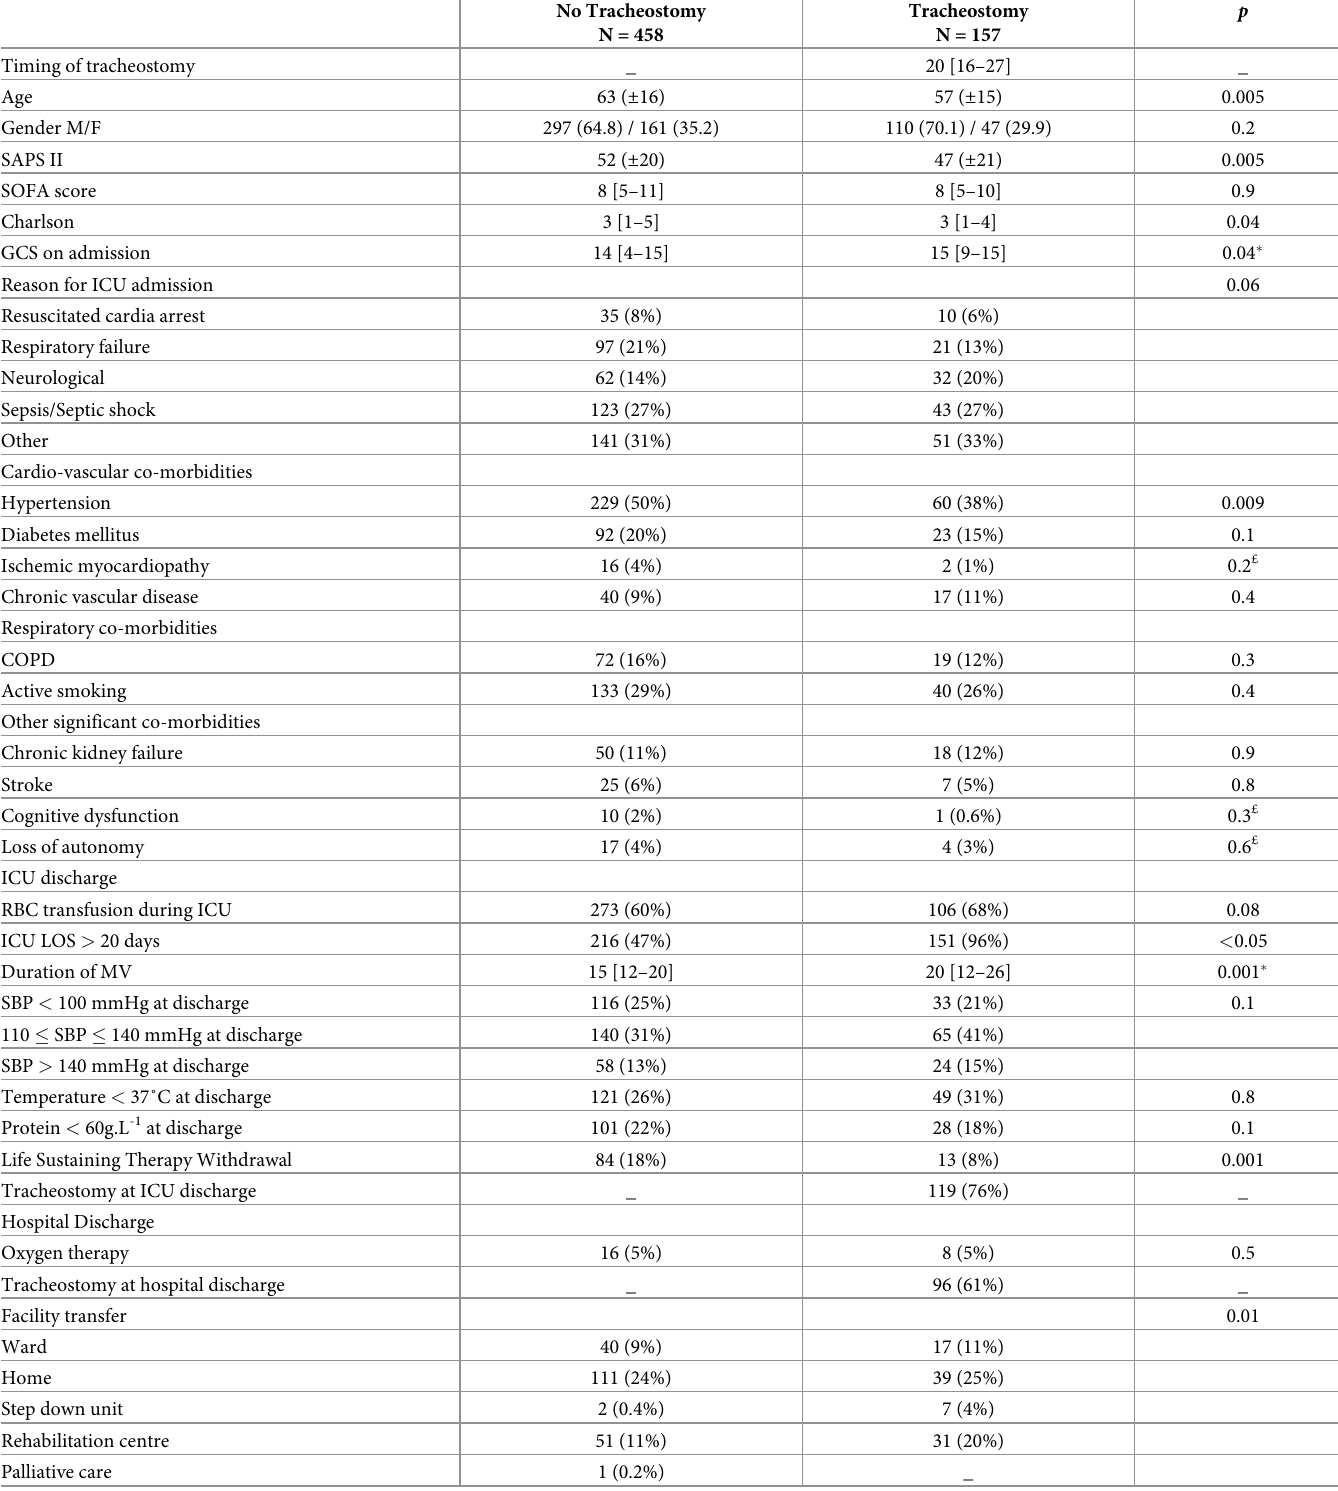
Table 1. Baseline characteristics of patients undergoing prolonged mechanical ventilation with or without